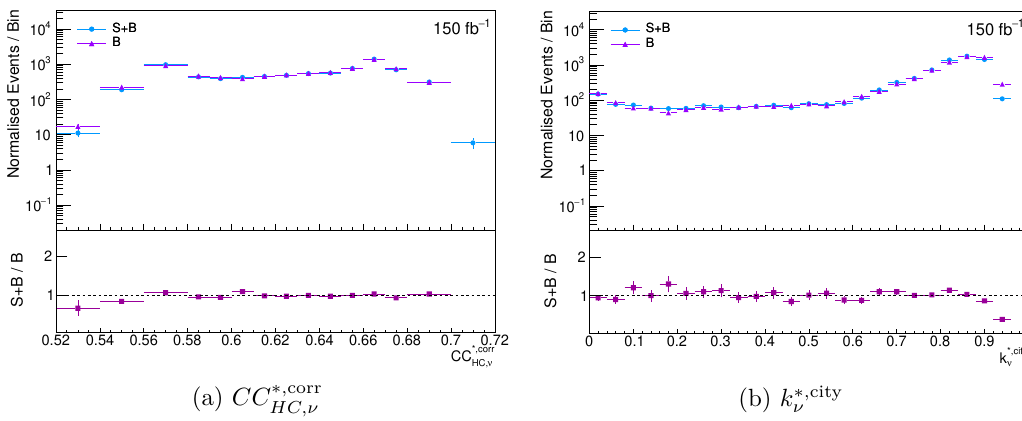
Figure 6. Event rates as functions of C ∗ , euc and k ∗ , city for WZ background events calculated from s,ν ν either the signal-plus-backround or background-only network. These two networks use different sets of simulated WZ events. Events in the overflow bin are not shown in the